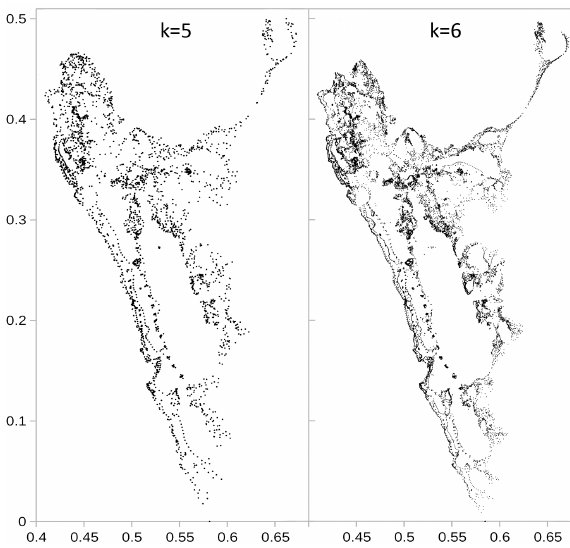
Figure 4. Spectrum of SC (3 ; 1 ; k ) in the vicinity of the real axis (magnification of the blue rectangle of Fig. 2).